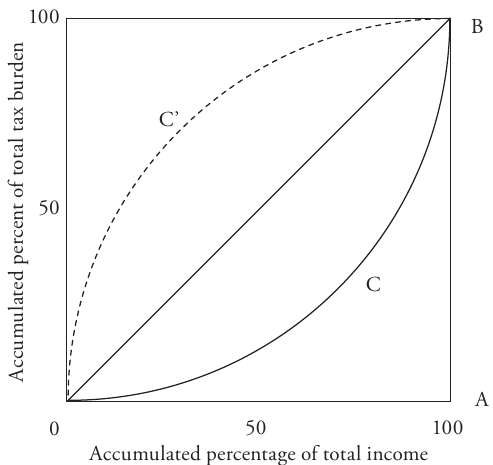
Figure : Illustration of the Suits